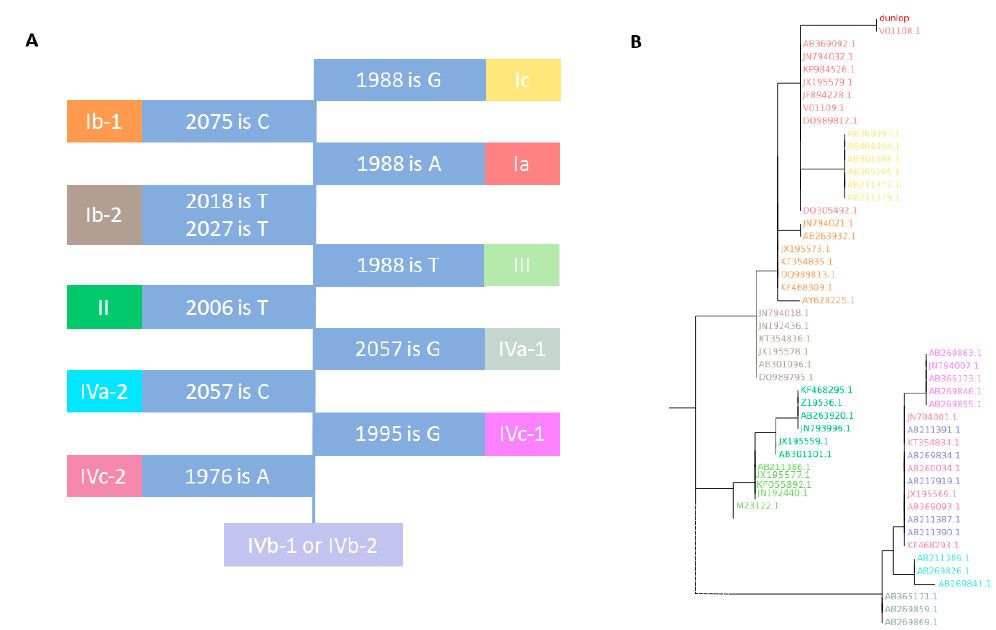
Figure 1. Graphical representation of BKTyper VP1 genotyping and phylogeny block identification. Subpanels ( A) and ( B) represent the different steps of the algorithm. ( A) , decision tree to genotype VP1 from Morel et al. [13]. Blue boxes represent coordinates for specific positions from the polyomavirus BK Dunlop strain (V01108.1) reference and the nucleotide that needs to be present to stop the decision tree. If true, the subgroup corresponds to the contiguous colored box. If another nucleotide is found at the given position, the following colored box must be checked. ( B) , ML phylogenetic tree that corresponds to the typing of a Dunlop strain VP1 with the internal database of BKTyper. Colors represent the different subtypes (shared in panel A ). Query sequence “dunlop” is highlighted in red. Table 2. BKTGR coordinates correspondence and its specific motifs. Genome coordinates are based on polyoma BK Dunlop strain (V01108.1) reference. VP1 coordinates correspond to nucleotide coordinates of the same reference using the first base of the gene as a starting position. The conserved motif corresponds to the motif used to transport coordinates from the reference to the query sequence (first nucleotide of the motif). Genome Coordinates VP1 Coordinates Conserved Motif 1989